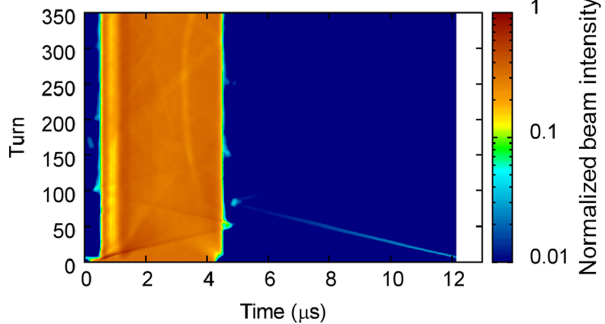
FIG. 4. Evolution of the beam intensity profile in the SBB